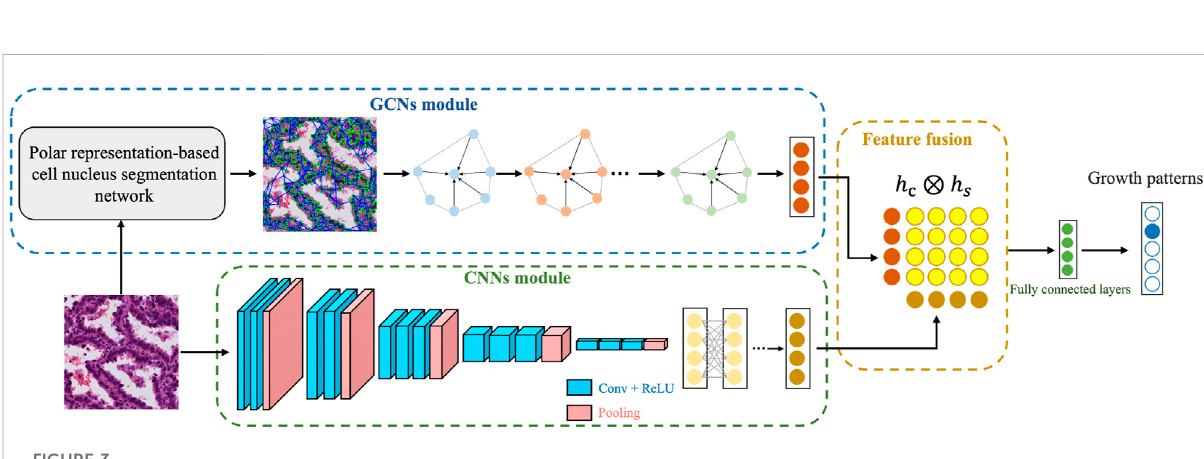
FIGURE 3 Overview of the proposed diagnostic methods for lung